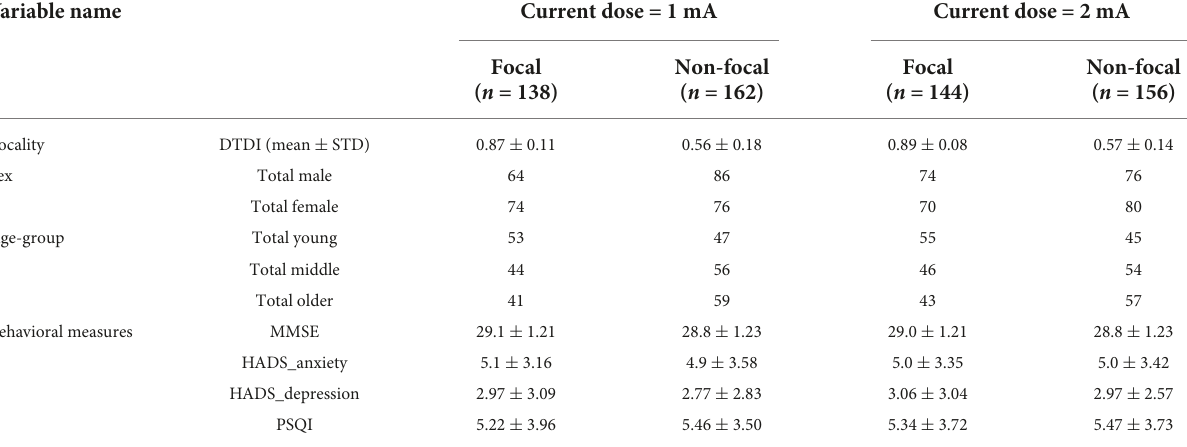
TABLE 1 Enlists the composition of the focal and non-focal group for the montage F3-RSO and the two current doses (1 and 2 mA).